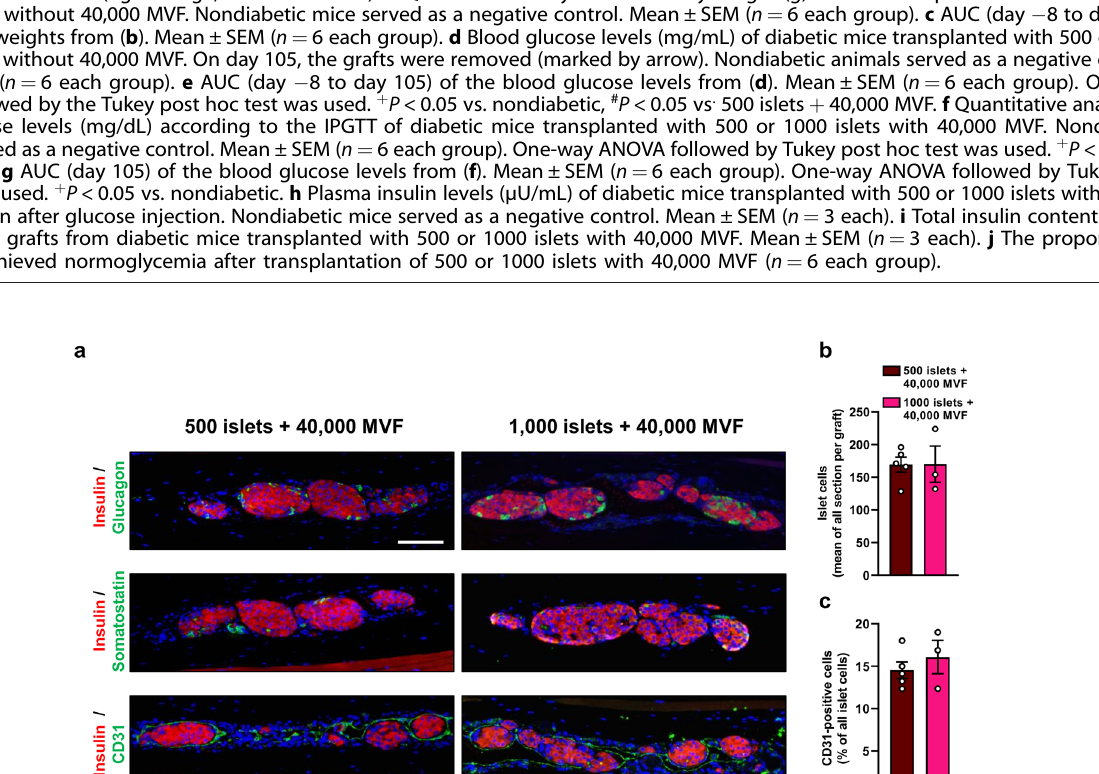
Fig. 5 Immunohistochemical analysis of the grafts in the subcutaneous space. a Immuno fl uorescent stainings of insulin/glucagon, insulin/ somatostatin, and insulin/CD31 within the group of 500 or 1000 islets with 40,000 MVF on day 105 after subcutaneous transplantation. Scale bar: 100 µm. b Quantitative analysis of islet cells (mean of all sections per graft) within the group of 500 ( n = 5) or 1000 ( n = 3) islets with 40,000 MVF. Mean ± SEM. c Quantitative analysis of CD31-positive cells (% of all islet cells) within the group of 500 ( n = 5) or 1000 ( n = 3) islets with 40,000 MVF. Mean ±